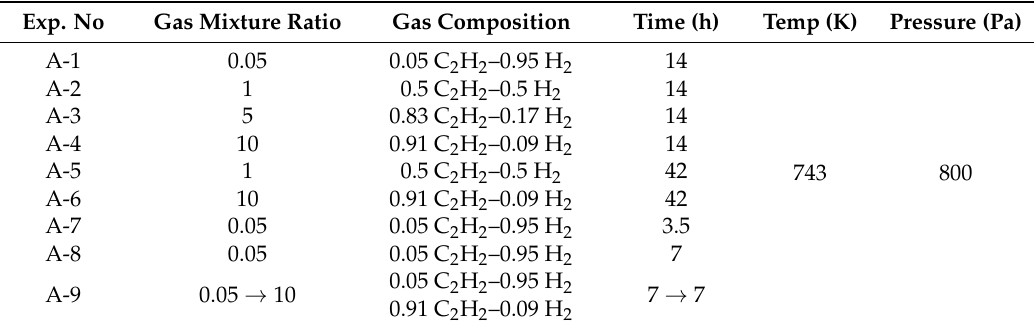
Table 2. Experimental conditions of direct low-temperature vacuum